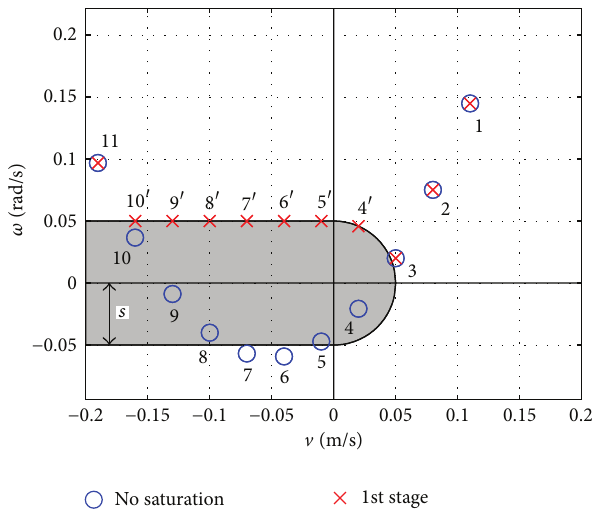
Figure 6: First stage representation of 𝑆 with saturation